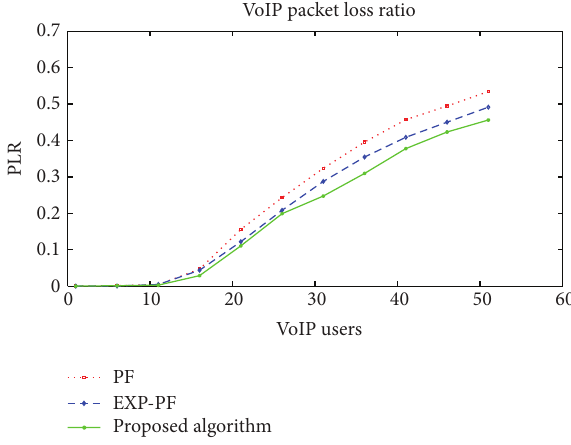
Figure 6: VoIP packet loss